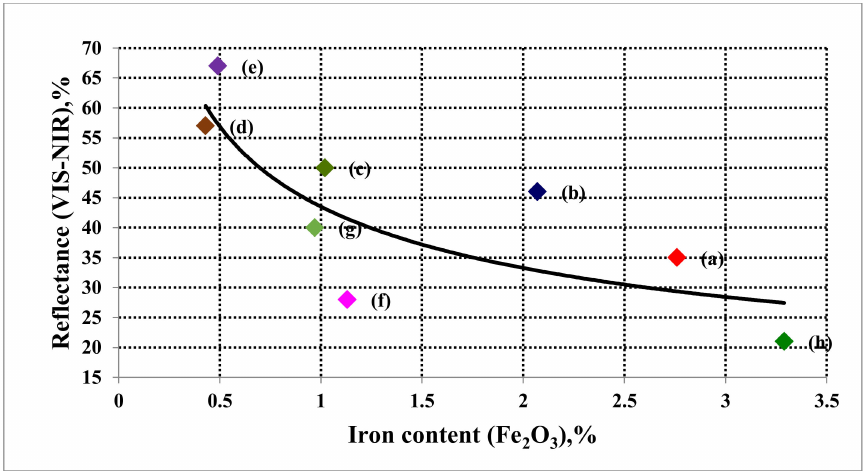
Figure 10. Relationship between iron content and reflectance of igneous rock types in the VIS-NIR region (400–1000